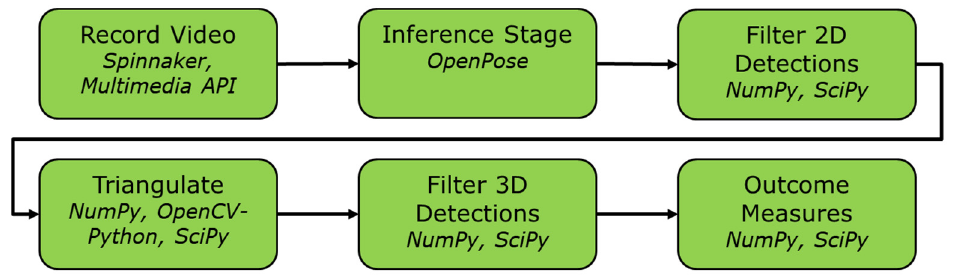
Figure 6. Leg angles measured during full strides. ( a ) hip angle, ( b ) knee angle, ( c ) ankle angle. Figure 7 shows the final software pipeline of the Smart Hallway.